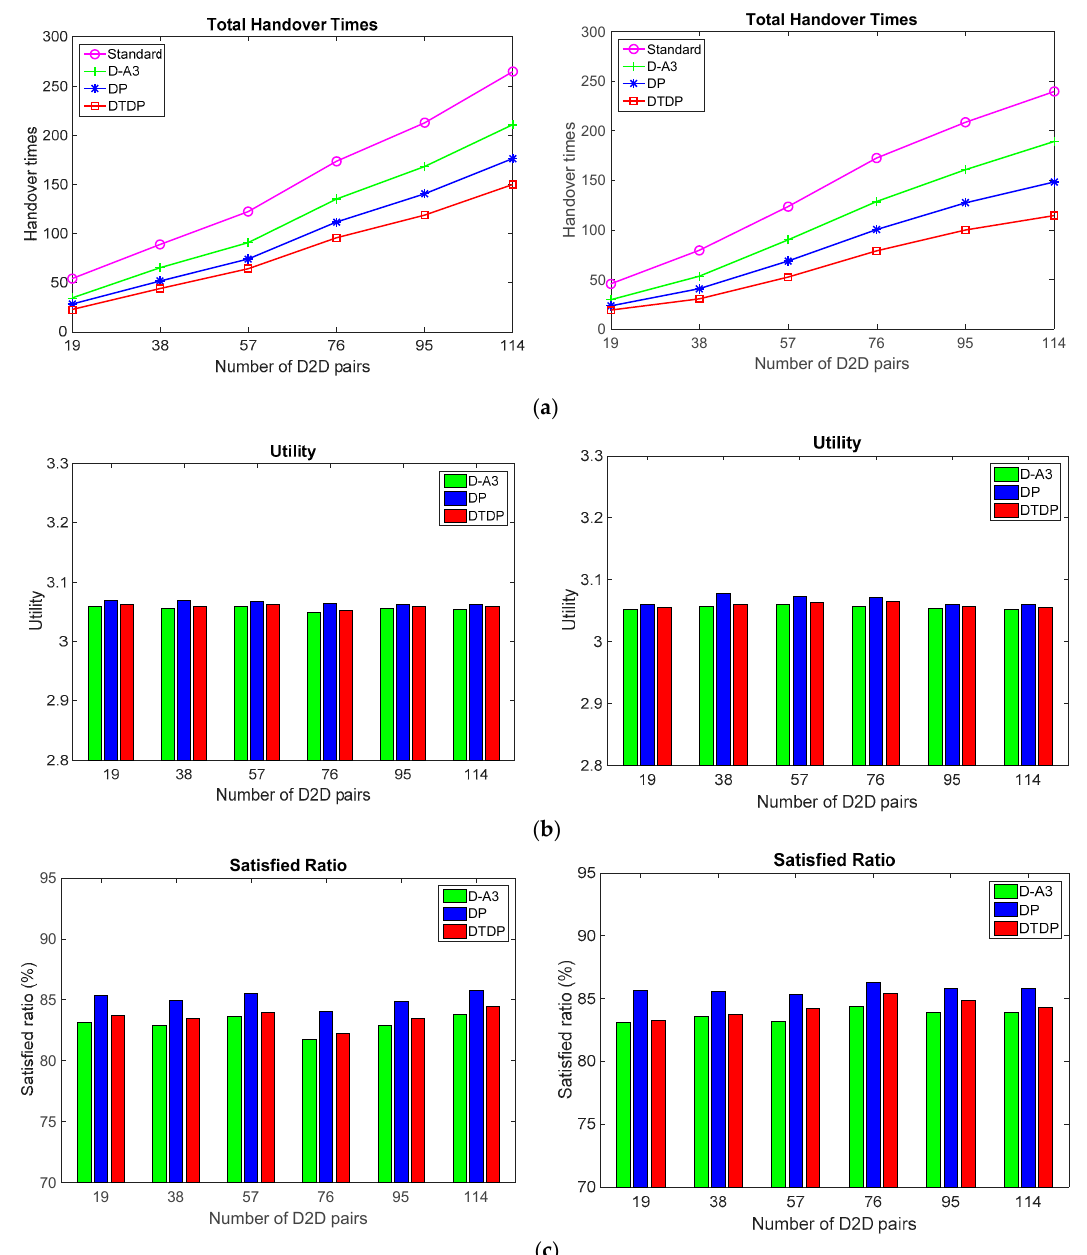
Figure 4. Total number of handover, utility, and satisfied ratio versus the number of device-to-device (D2D) pairs under different mobility models. The charts on the left and the charts on the right correspond to the fixed distance (FD) model and reference point group mobility (RPGM) model, respectively. ( a ) Total number of handovers; ( b ) utility; ( c ) satisfied ratio.